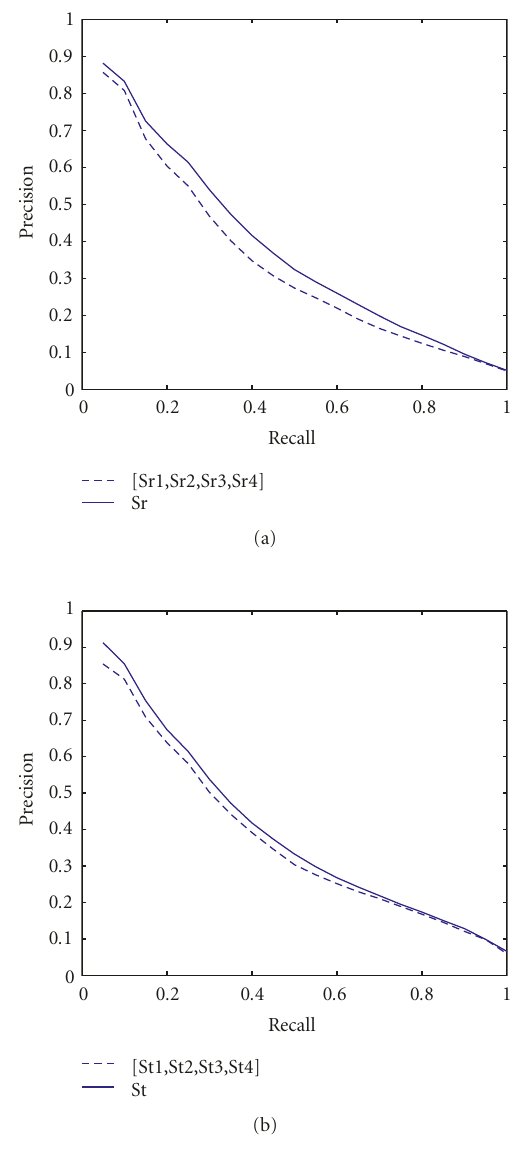
Figure 6: Precision-recall curves for [Sr1,Sr2,Sr3,Sr4] versus Sr (a) and [St1,St2,St3,St4] versus St (b) on